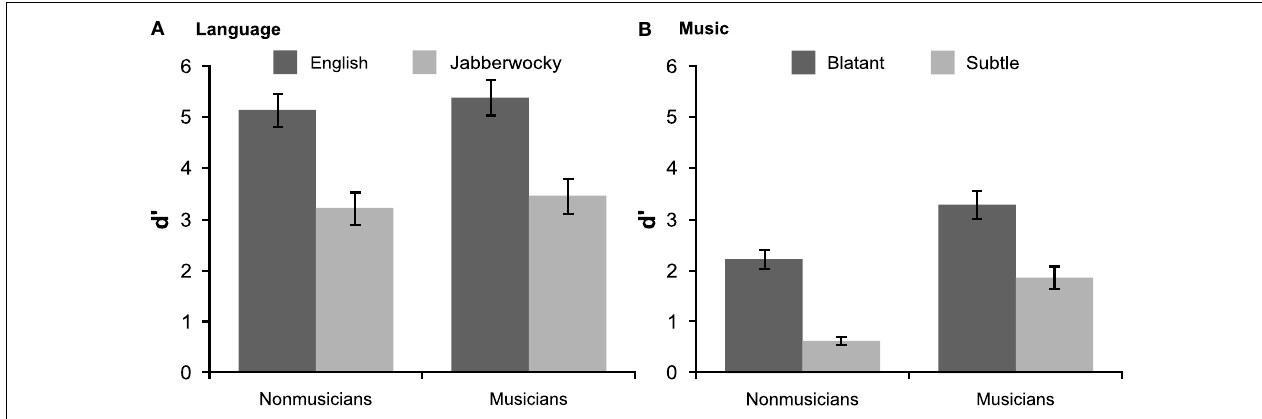
FIGURE 3 | Behavioral results. Performance on the grammaticality judgment task is shown for (A) language and (B) music with standard error bars.